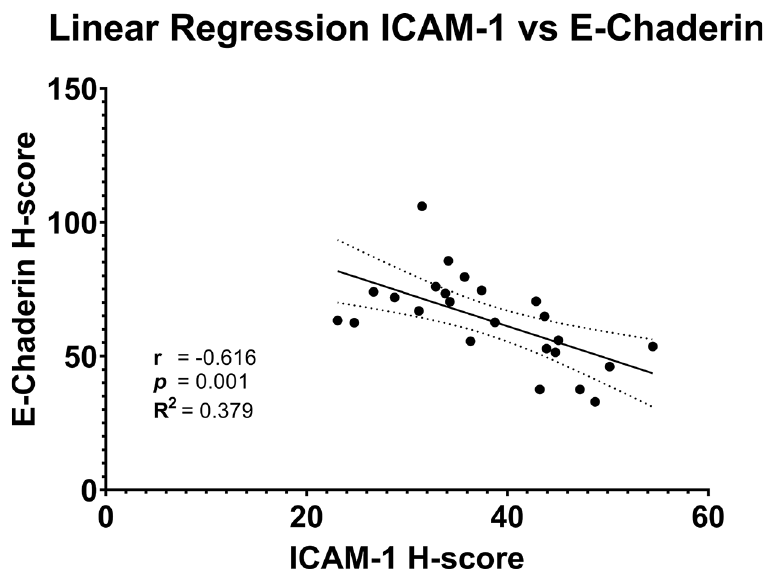
Figure 4. Correlation between ICAM-1 and E-Cadherin